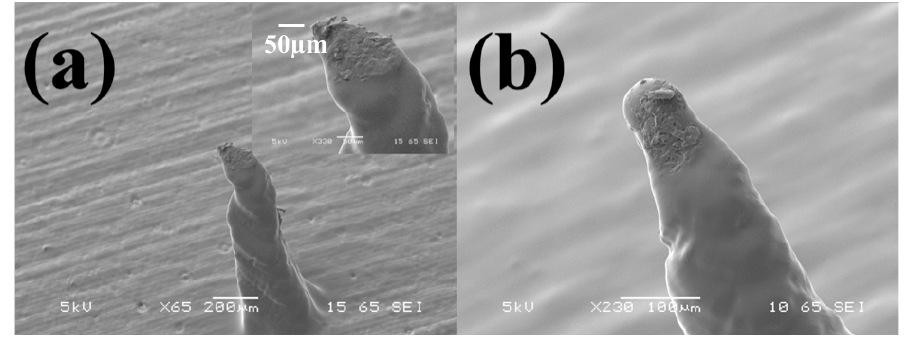
Figure 8 . The effect of temperature curing of the microneedles (MNs)—( a ) No temperature curing and ( b ) curing cycle of 60 °C for 60 min depicting intact tips when subject to a puncturing force of 10 N/patch.